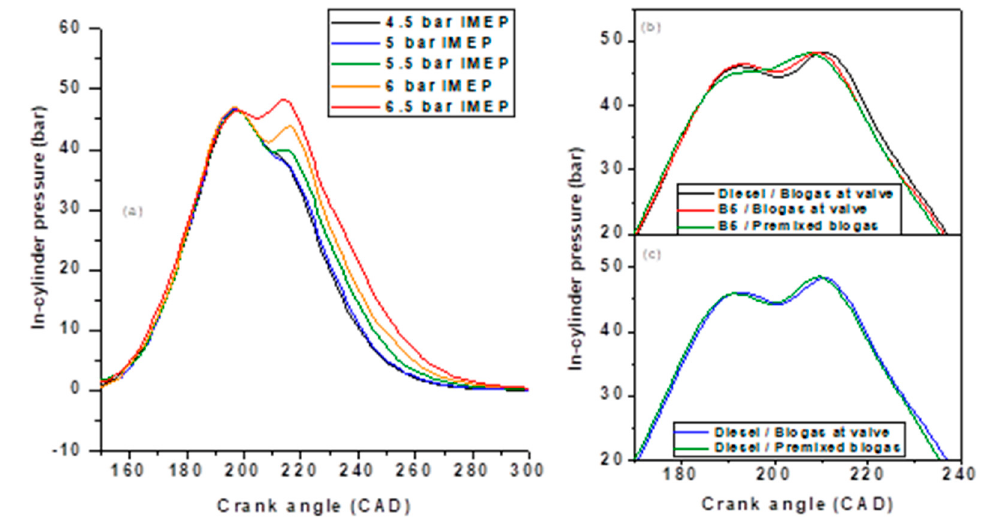
Figure 4. In-cylinder pressure traces for ( a ) combustion of B5/biogas injected at valve for various loads, ( b ) B5/biogas RCCI in premixed and injection at valve for 6.5 bar IMEP, and ( c ) diesel/biogas in a premixed and port injection at valve 6.5 bar IMEP.